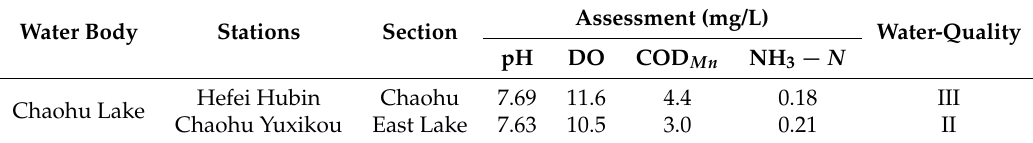
Table 1. Water-quality data of Chaohu Lake by the China National Environmental Monitoring Center, on the 22nd week of